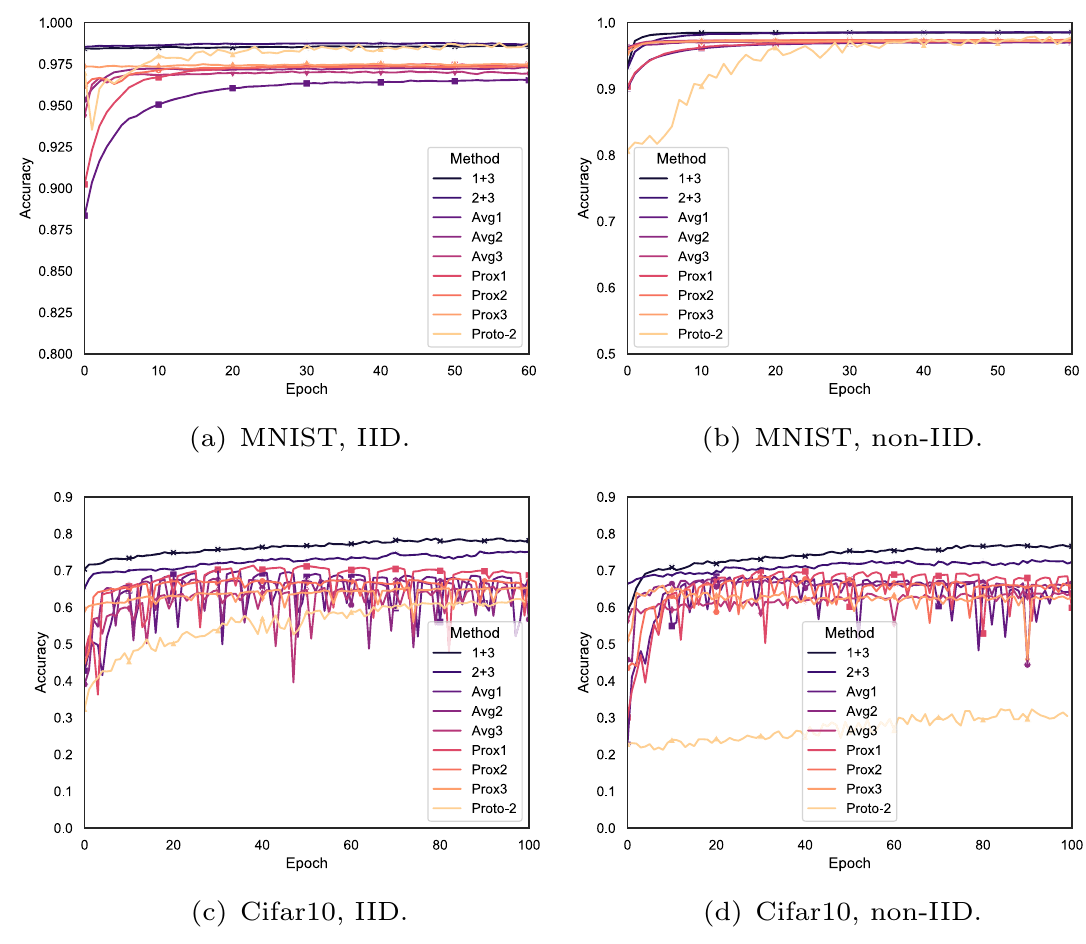
Fig. 4 Two-level heterogeneity performance comparisons of image datasetsunderIIDandnon-IIDdistributions.“1+3”representstwo-level heterogeneous FL consisting of the first branch and the third branch, while “2 + 3” is composed of the second branch and the third branch. “Avg1”, “Avg2”, and “Avg3” are all homogeneous FL. The server under “Avg1”, “Avg2”, and “Avg3” only includes single-exit models corre-